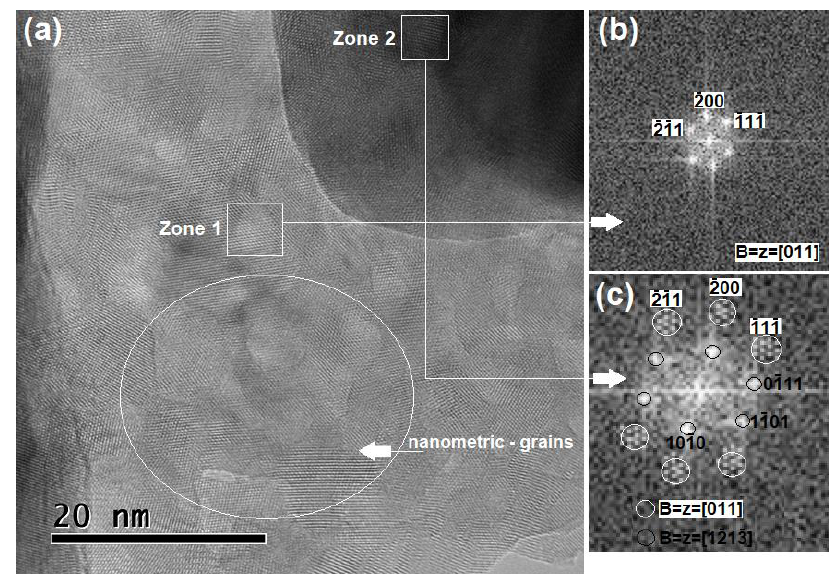
Figure 6. HRTEM micrograph of the extruded Zn-12.5Ag-1Mg alloy: ( a ) bright-field image showing nanometric grains with different atomic orientations; FTTs patterns of ( b ) Zone 1 and ( c ) Zone 2.